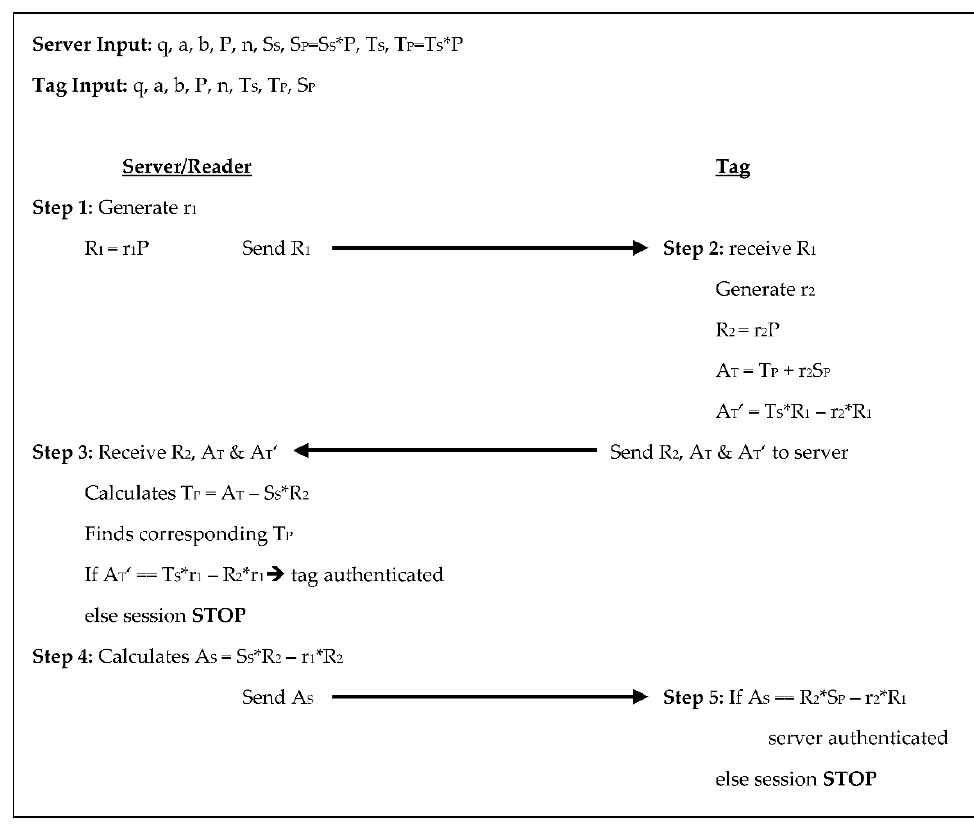
Figure 4. Authentication phases for Zheng et al. [5]